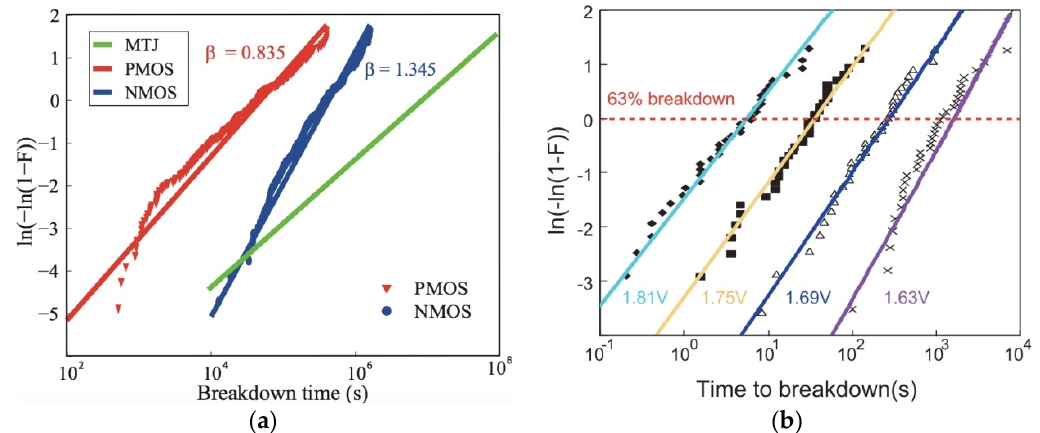
Figure 7. ( a ) The cumulative breakdown probability distribution in MTJ and 28-nm FD-SOI CMOS transistors [46]. Experimental results (fabrication and breakdown test from 28-nm FD-SOI CMOS) are demonstrated by the markers; ( b ) MTJ hard breakdown case study with 1.25 nm oxide barrier: Time-to-failure statistics at different stress voltages. The time value corresponds to 0 if Weibull function represents a 63% failure time [48].